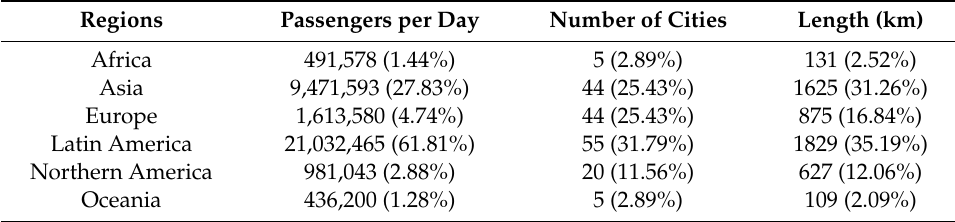
Table 1. Global Bus Rapid Transit (BRT) data.